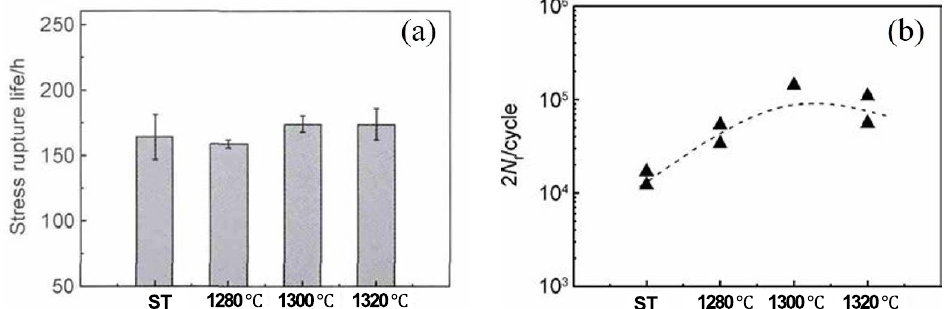
Figure 14. Micropore and eutectic content after HIP treatment with different temperature. ( a ) stress rupture life/h; ( b ) 2N f cycles of 760 °C LCF, the 2N f cycles of each state are tested once or twice, as shown in the black triangle [30] .